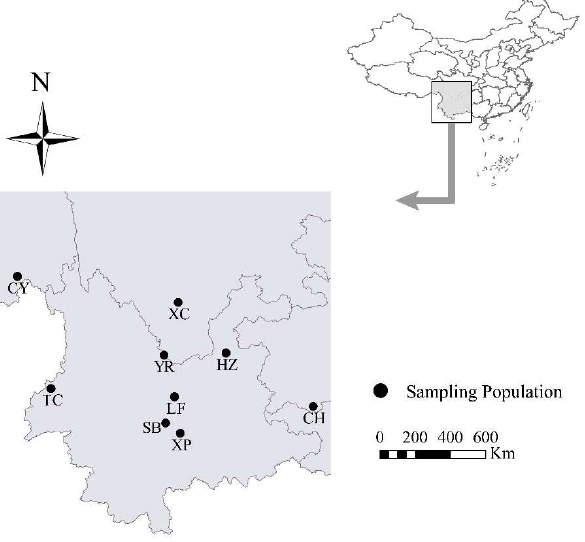
Figure 1. Locations of nine sampling populations of P. yunnanensis . Table 1. Geographical locations and main climatic conditions for the nine P. yunnanensis popula- tions sampled. Population